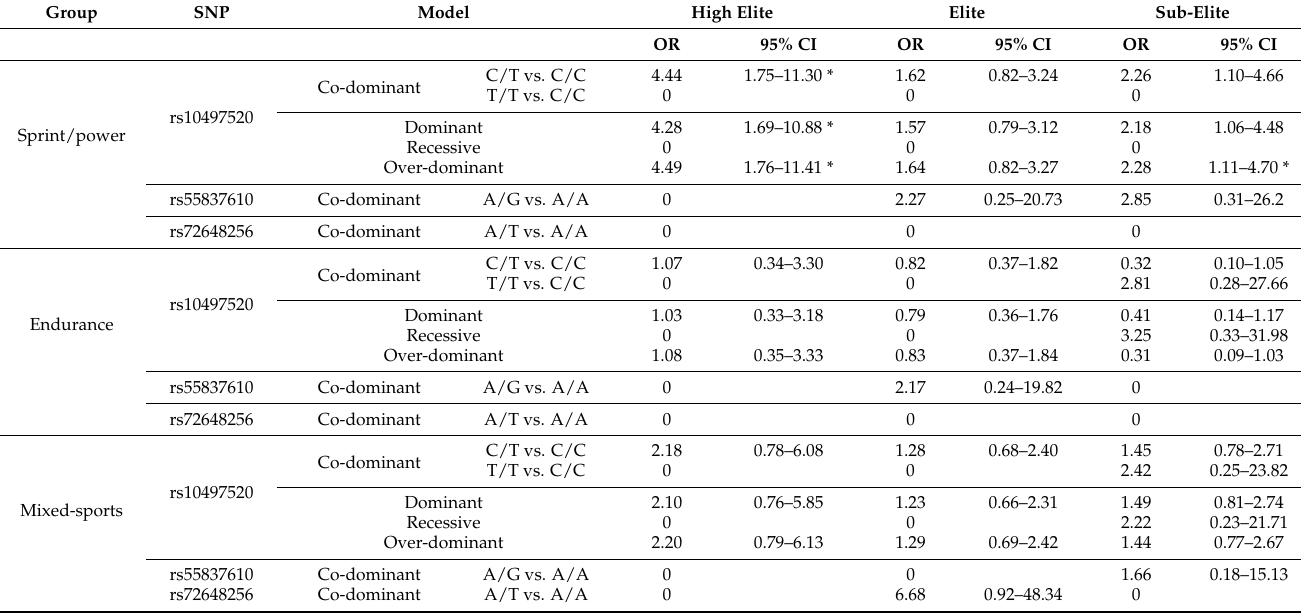
Table 5. Odds ratios with 95% confidence interval for comparisons of athletes (stratified by sport discipline and athletic performance) and controls.